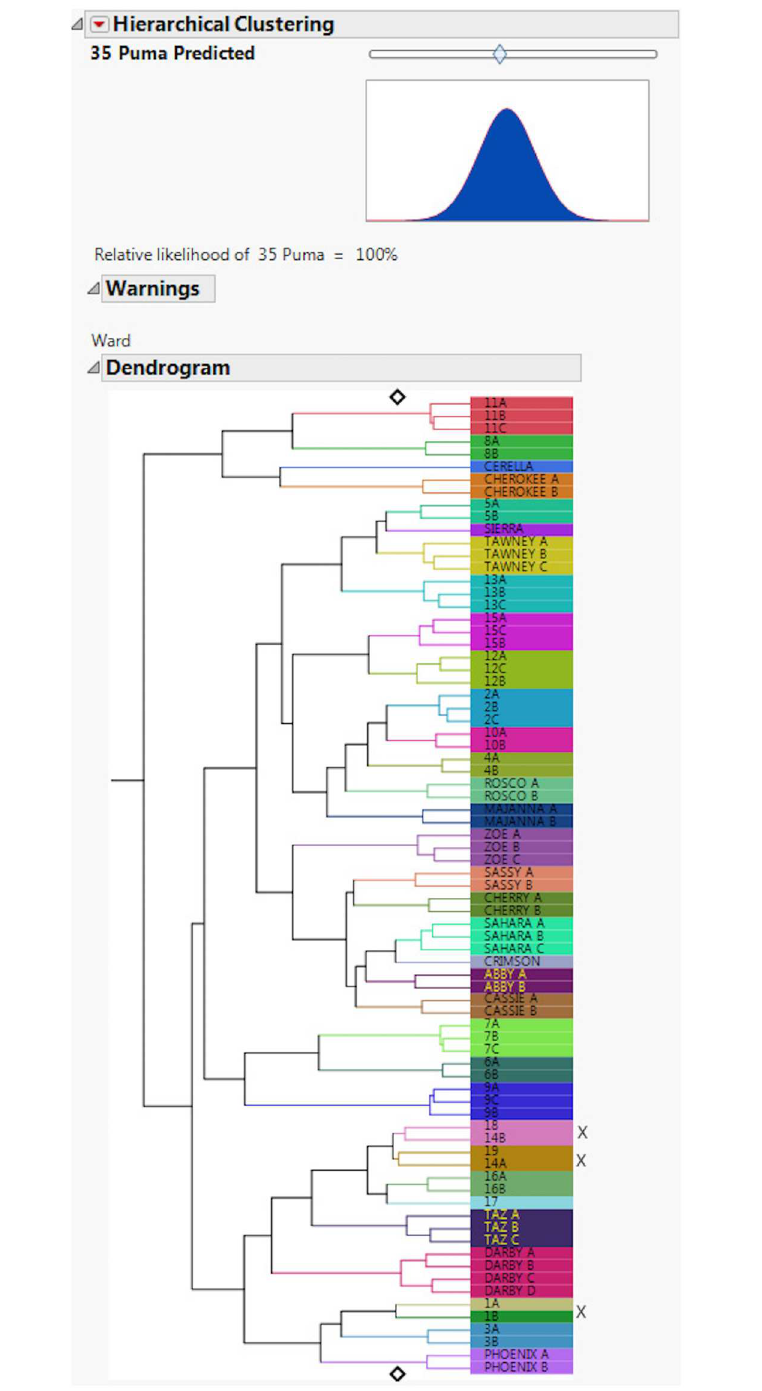
Fig 6. This figure shows the classification dendrogram output from FIT. Three trails of 77 were misclassified (indicated by an x), givingan overall accuracy of individual identificationfor correct trail placementof